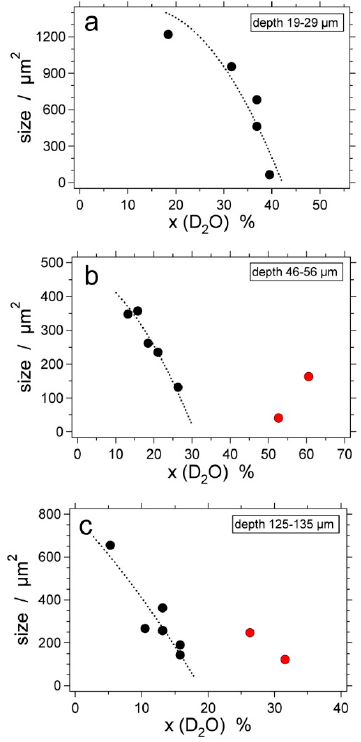
Figure 11. D 2 O composition versus fluid inclusion size (in µm 2 ), as observed from two-dimensional projections in microscope images after re-equilibration experiment with GMR-004a , at specific depths: ( a ) 19–29 µm; ( b ) 46–56 µm; and ( c ) 125–135 µm. The dashed lines are concentrations according to classical diffusion models [8]. The red symbols are defined in Figure 10.